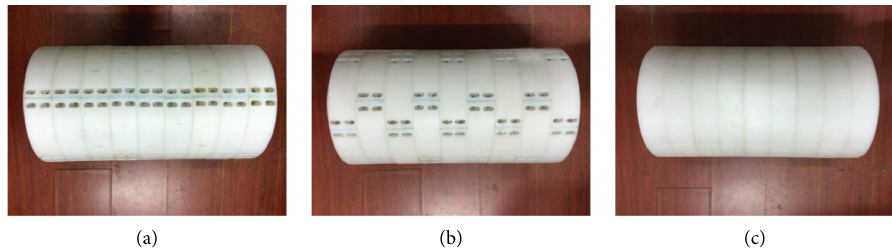
Figure 4: Photographs of the three types of ring models. (a) Straight-jointed ring. (b) Stagger-jointed ring. (c) Uniform ring.